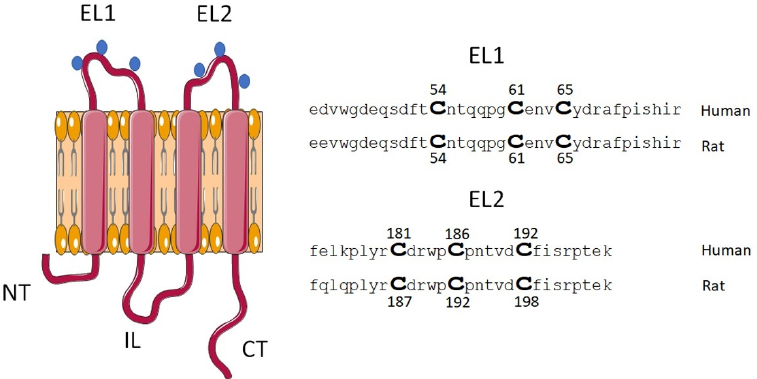
Figure 8. Schematic representation of the localization of extracellular Cys of Cx46. The diagram shows the topological disposition of Cx46 at the plasma membrane and the approximate location of extracellular Cys residues (blue dots). In this study, we used Cx46 derived from human and rat, where Cys located at the EL1 are identical, however, the Cys at EL2 show differences in location within the primary sequence, which are homologous in function. Table 1. Site-directed mutagenesis primers for hCx46 extracellular Cys mutations.